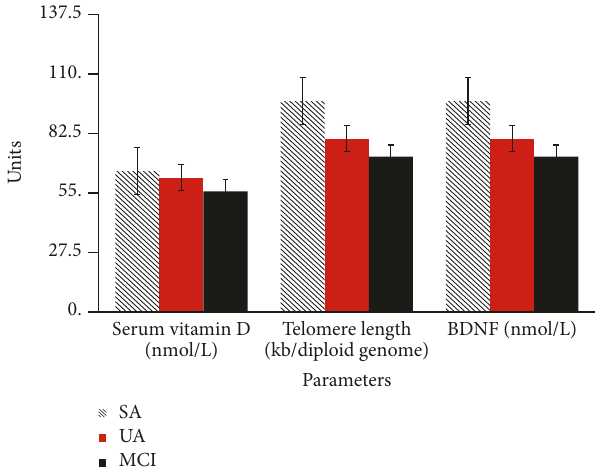
Figure 1: Comparison of selected neuroprotective factors between ageing groups. BDNF: brain-derived neurotrophic factor; SA: suc- cessful ageing; UA: usual ageing; MCI: mild cognitive impairment. One-way ANOVA and post hoc test LSD. Serum vitamin D and BDNF significant between MCI and SA; telomere length significant between UA and